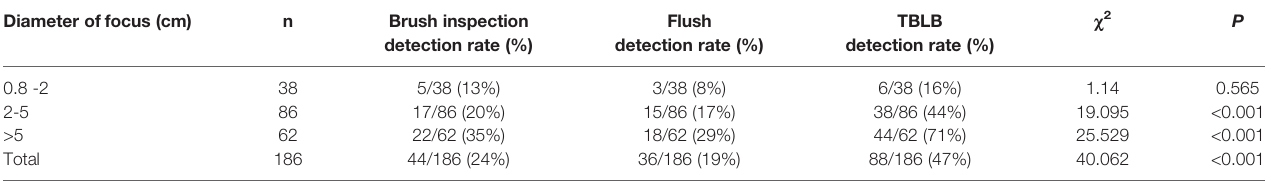
TABLE 4 | Comparison of different sampling methods for different lesions of different sizes under fi beroptic bronchoscopy. Diameter of focus (cm)